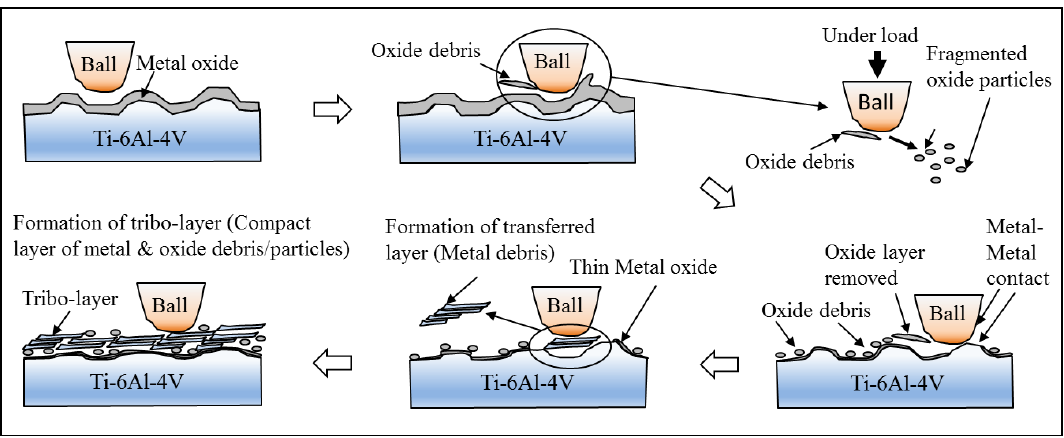
Figure 12. Schematic road-map on the formation of tribo-layer during sliding wear of Ti64 samples.